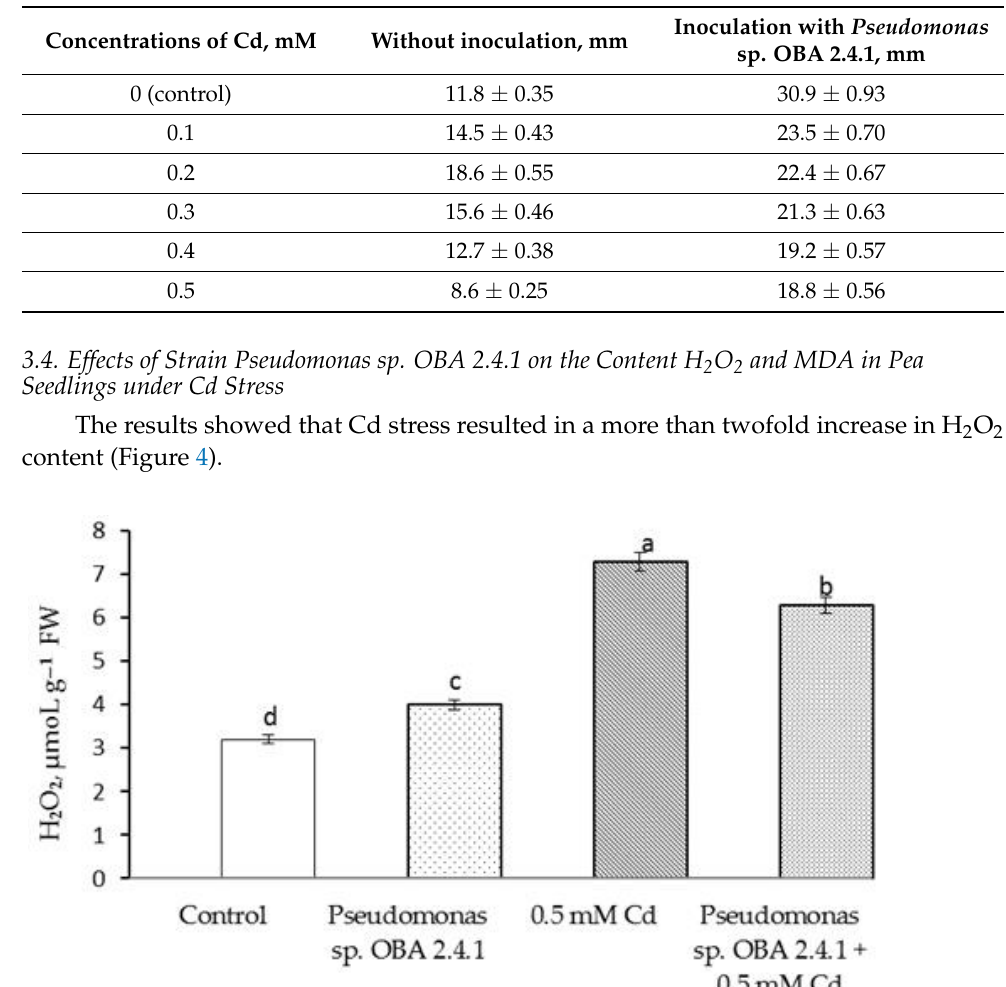
Table 1. Average length of seedlings of pea plants under different concentrations of cadmium. The presented data are the average of three repetitions (n = 50).